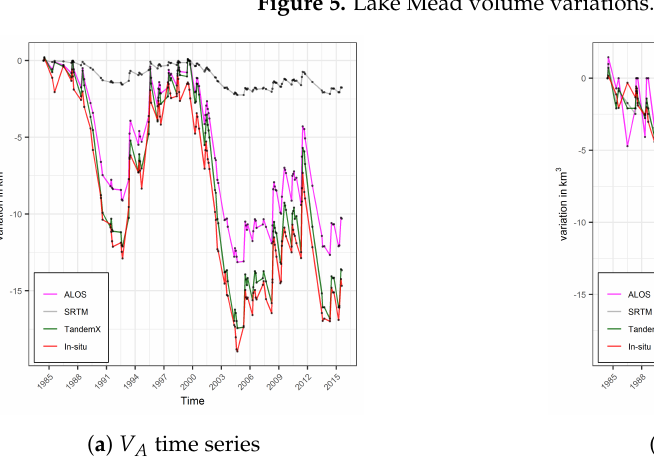
Figure 6. Lake Powell volume